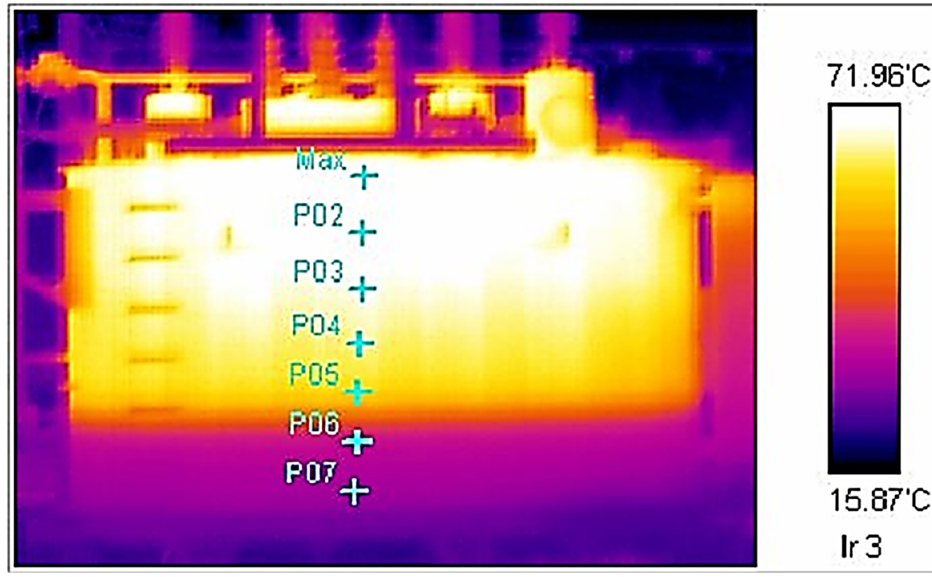
Figure 11. Transformer thermographic photograph [43].